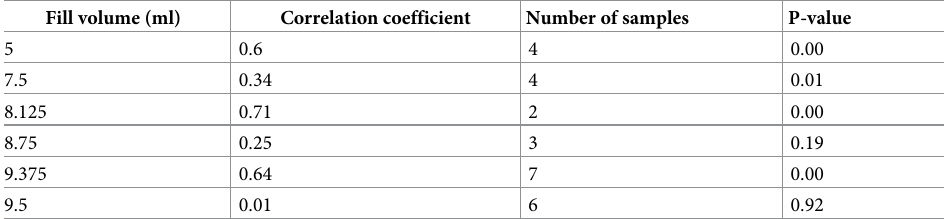
Table 5. Correlation coefficients of water depth and vertical velocity for rising floats filled with different volumes of